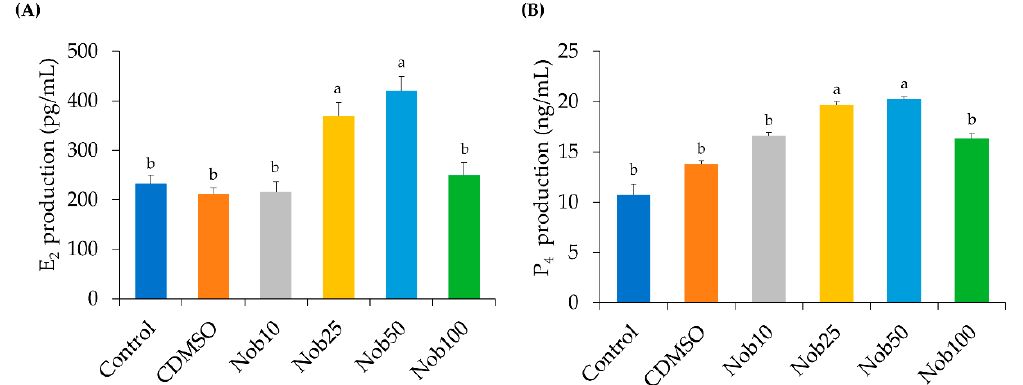
Figure 5. Steroidogenic production of cumulus cells (CCs) after in vitro maturation using different concentrations of nobiletin. ( A ) Steroidogenic production of Estradiol (E 2 ). ( B ) Steroidogenic production of Progesterone (P 4 ). Bars represent mean concentrations produced by CCs under each different experimental condition. Data are the mean ± SEM. Values with different superscript letters differ significantly ( p < 0.05).